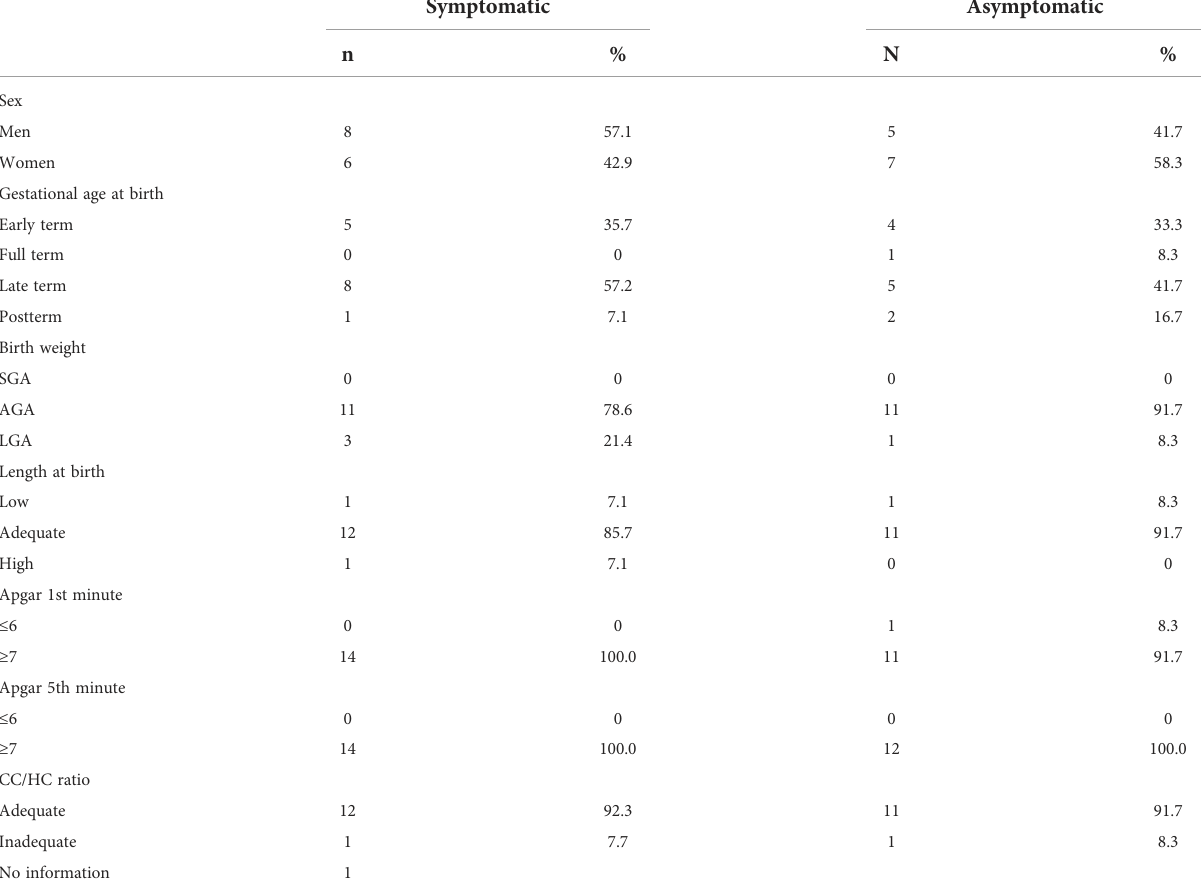
TABLE 3 Neonatal characteristics of symptomatic (n=14) and asymptomatic (n=12) for Covid-19 of lactating women, during pregnancy.